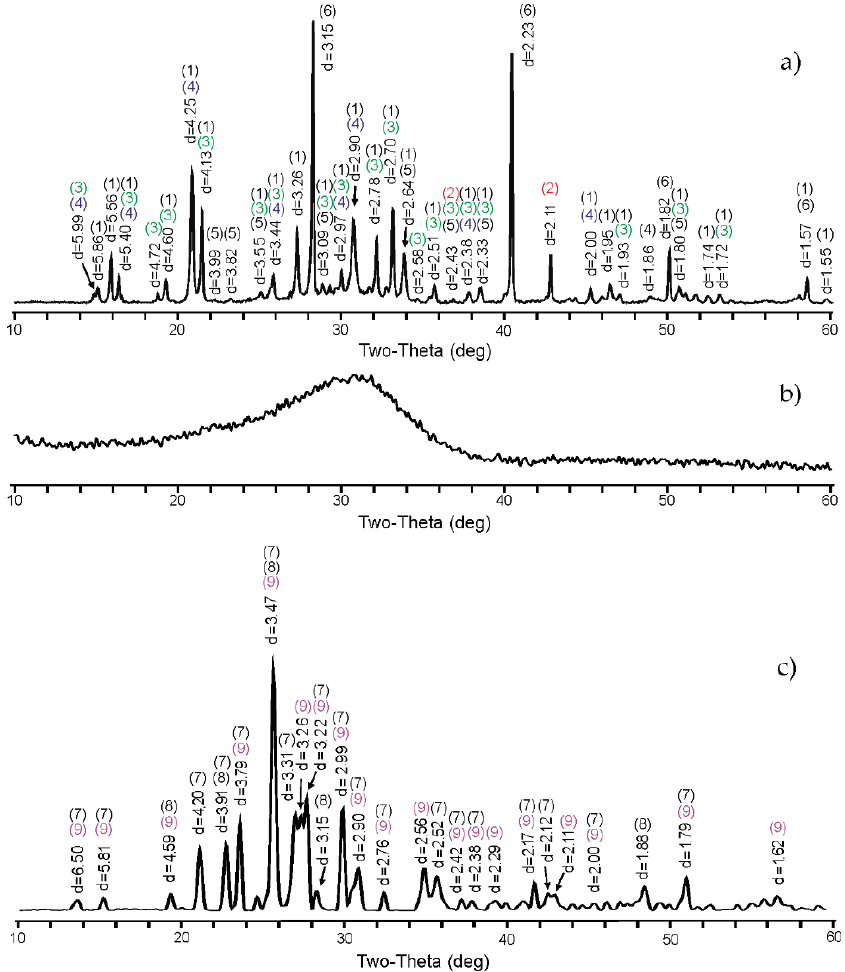
Figure 1. X-ray diffraction patterns of the materials containing spent electrolyte imitator: ( a ) MPP matrix, ( b ) NAFP glass and ( c ) ceramics based on bentonite clay. 1–MgKPO 4 ·6H 2 O (K-struvite); 2–MgO (periclase); 3–MgHPO 4 ·6H 2 O (newberyite); 4–MgCsPO 4 ·6H 2 O; 5–Li 3 PO 4 (lithiophosphate); 6–KCl (sylvite); 7–KAlSi 3 O 8 (orthoclase); 8–LiAlSi 3 O 8 ; 9–SrAl 2 Si 2 O 8. Crystalline phase formation was not detected on the surface of NAFP glass (Figure